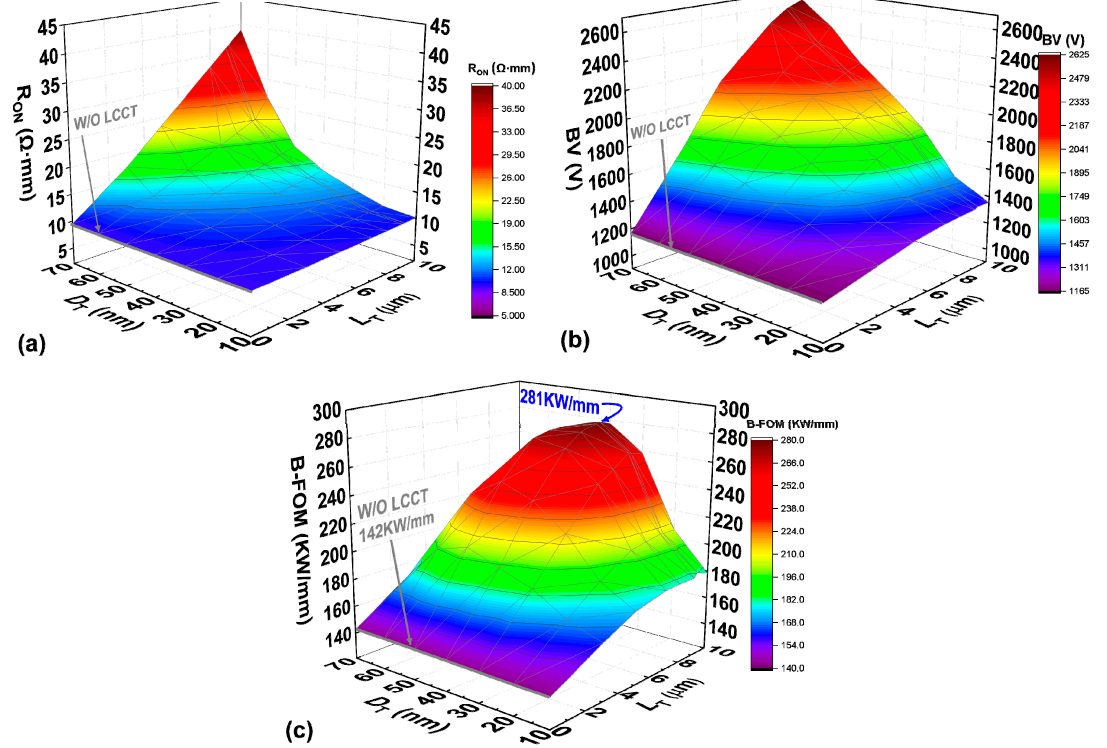
Figure 7. The extracted ( a ) on-resistance, ( b ) corresponding breakdown voltage (BV), and ( c ) Baliga Figure-of-Merits (BFOM) of proposed LCCT-HEMT with different LCCT configurations.